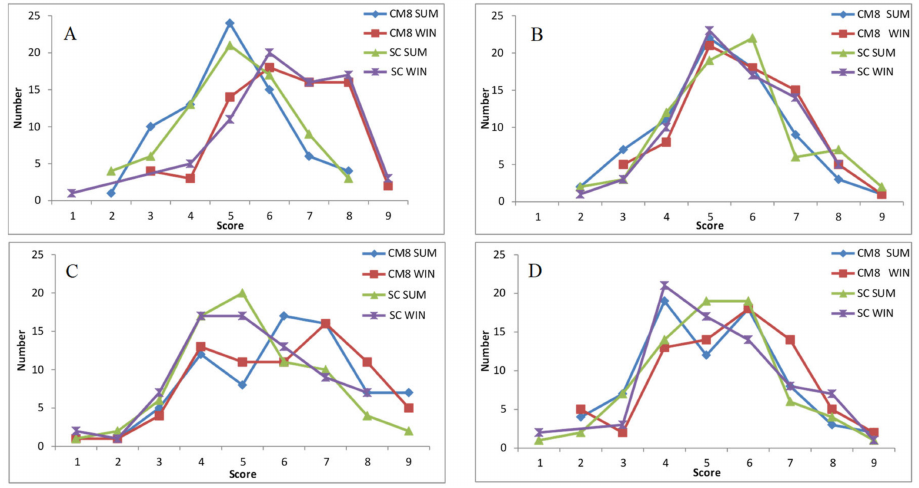
Figure 2. Sensory evaluation results on color ( A ), aroma ( B ), flavor ( C ), and overall preference ( D ) of four red wines. Y axis = panelist number; X = hedonic 9-ponit score. Samples are explained in Table